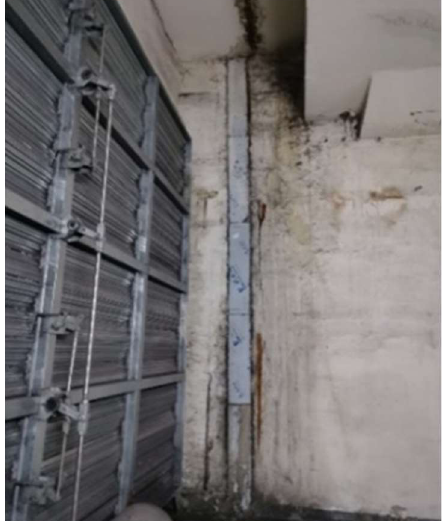
Figure 1. Case of underground engineering